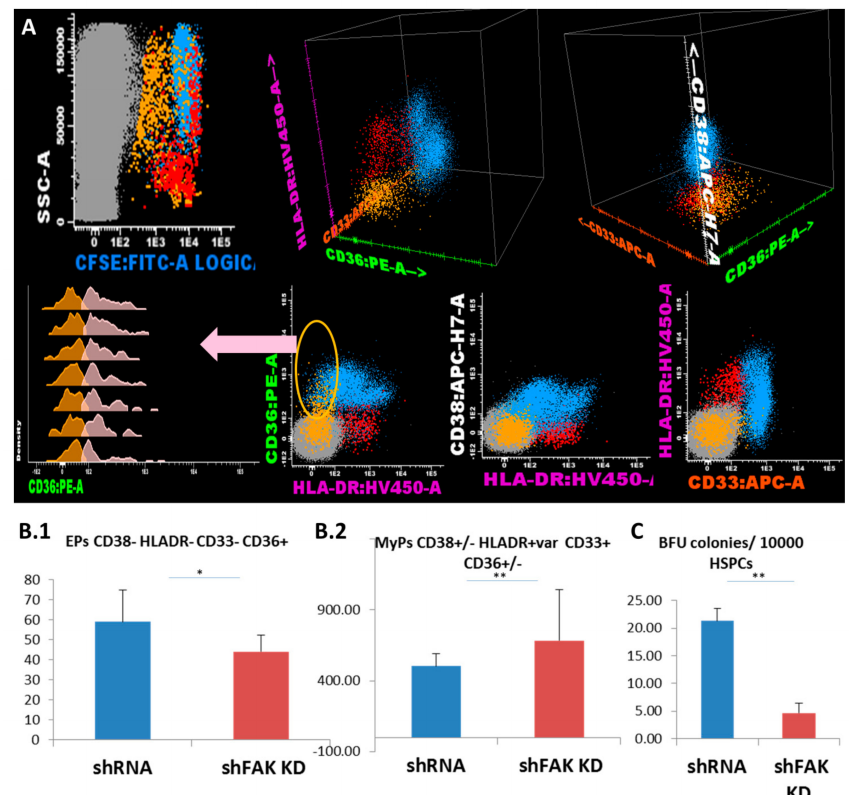
Figure 5. FAK-deficient HS-5 cells negatively regulate the di ff erentiation capacity of CD34 + HD-HSPCs towards erythroid lineage and promote the di ff erentiation of other myeloid progenitors. ( A ) Flow cytometry evaluation of the di ff erentiation capacity of CD34 + HD-HSCs after direct contact with FAK shRNA HS-5 cells during five days versus co-cultures with control shRNA. ( B ) Megakaryocyte / erythroid progenitors (MEPs) CD38- HLADR- CD33- (yellow dots), erythroid precursors (EPs) CD36 + CD33- HLADR- (pale pink dots), and other myeloid precursors (MyPs) CD33 + can be divided by the expression of CD36 in the monocyte-committed precursors CD38 + CD36 + CD33 + HLADR + (MPs, pale blue dots) and non-monocytic precursors CD38 + low / - CD36- CD33 + low / - HLADR + (red dots). The absolute cell count of EPs (n control shRNA = 3, n shFAK = 3; Figure 5B1) and of other MyPs (n control shRNA = 3, n shFAK = 3; Figure 5B2) recovered from CD34 + HD-HSCs from after five days of direct co-cultures with FAK shRNA HS-5 cells compared to control shRNA. ( C ) BFU-E colonies recovered from non-adherent HSPCs after five days of co-cultures with FAK shRNA HS-5 cells compared to control shRNA (n control shRNA = 3, n shFAK = 3). p < 0.05(*); p <